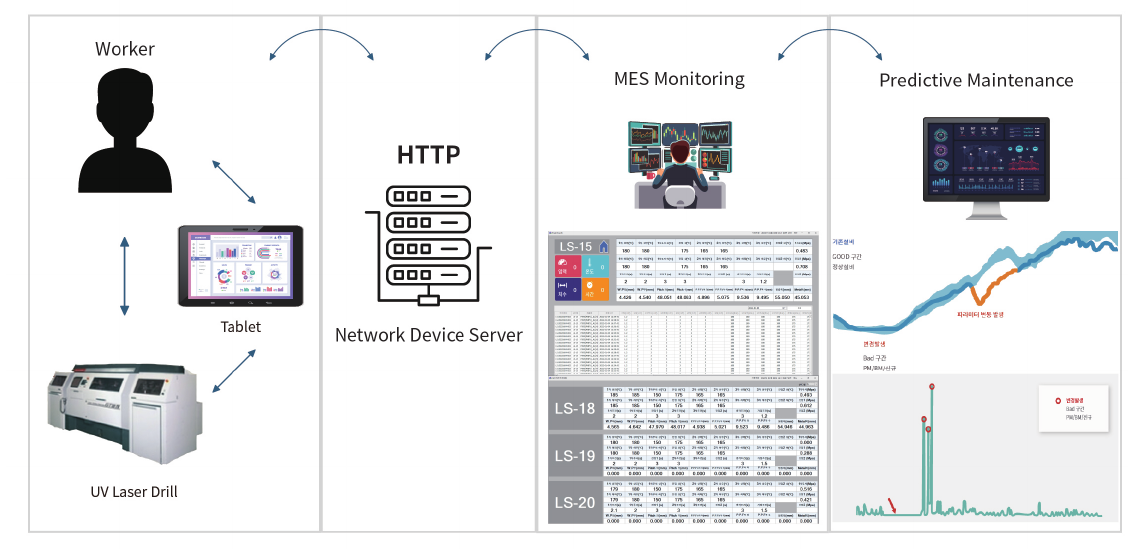
Figure 8. The structure of our smart factory monitoring